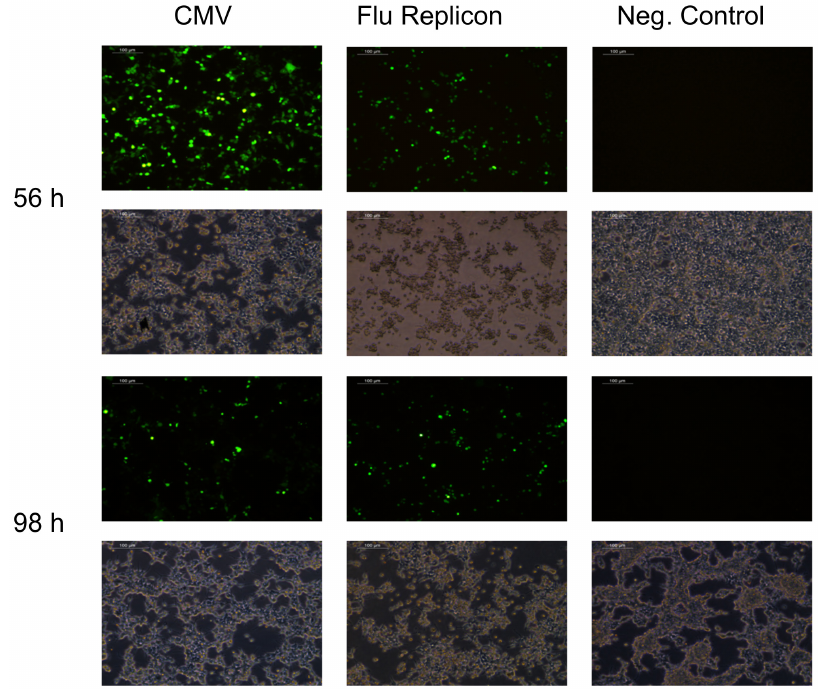
Figure 4. EGFP expression. HEK-293 cells were either tranfected with pEGFP-N1 (CMV) or with the influenza replicon and pMono-EGFP (Flu Replicon). Pictures were taken 56 and 98 hours post transfection. Non-transfected cells were used as negative control (Neg. Control).